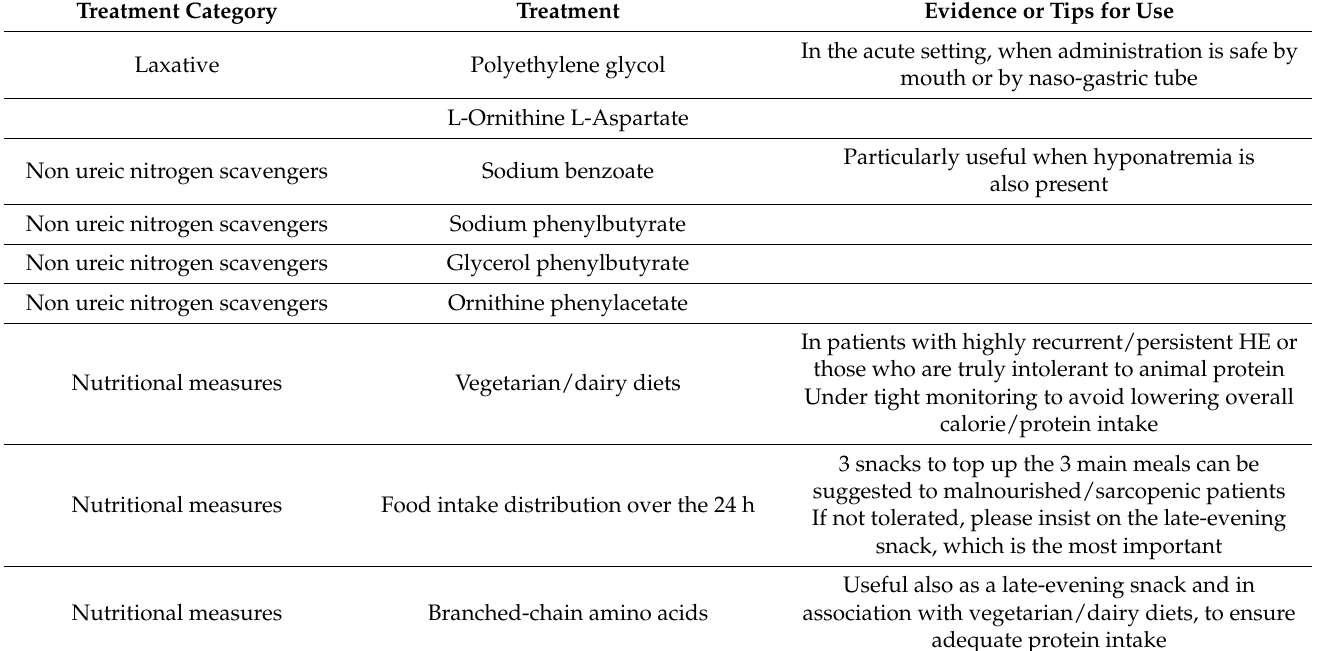
Table 1. Available treatments (other than general principles, non-absorbable disaccharides/antibiotics) with some commen- tary on the evidence for them and/or tips for